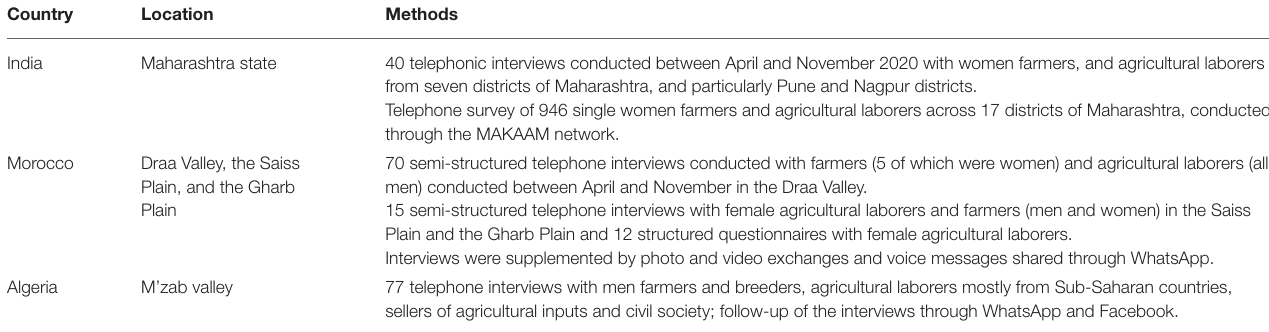
TABLE 1 | Methods used in the different study countries.